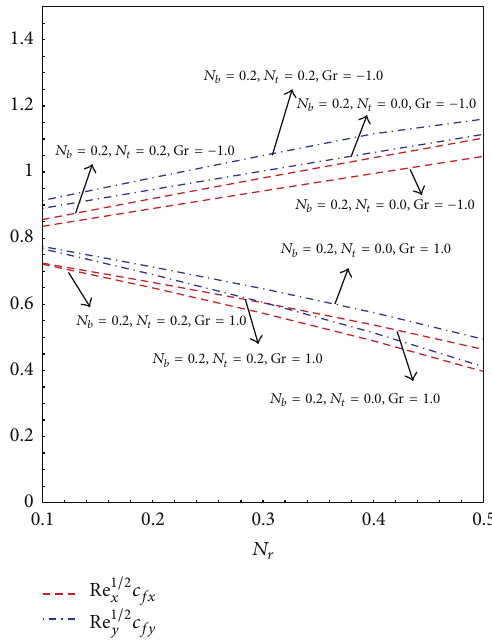
Figure 3: Graphs of skin friction coefficient along 𝑥 - and 𝑦 - direction for varying 𝑁 𝑟